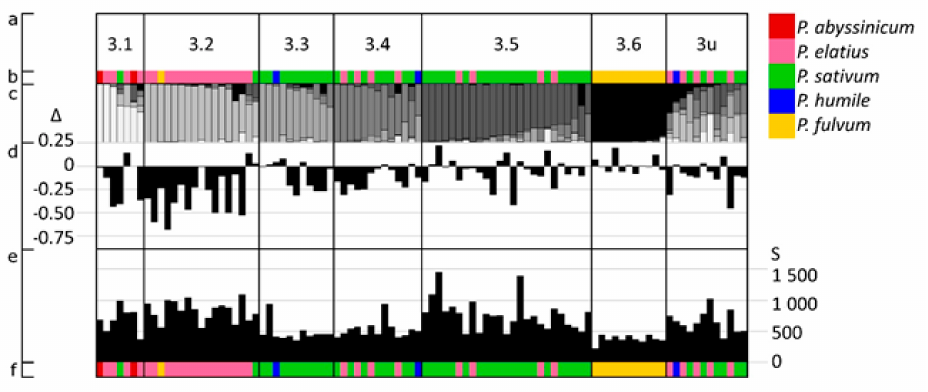
Figure 4. Pod, size and length: width ratio of 96 accessions from Structure group 3 of Jing et al. [12] with respect to subgroup assignments (Q). ( a ) Subgroup number, ( b ) taxa assigned according to the colors on the right. ( c ) Q plot of proposed parental assignment from [12] where each accession is represented by a vertical bar with grey shading for according to subgroup Q value. ( d ) The deviation of pod length: width ratio from its expectation is plotted as ∆ = ((L o /W o ) − (L p /W p ))/(L p /W p ) so that short-wide pods have a positive ratio and long-narrow pods have a negative ratio. The scale is on the left. ( e ) Pod size in mm 2 (S = L o W o ), with the scale on the right. ( f ) as ( b